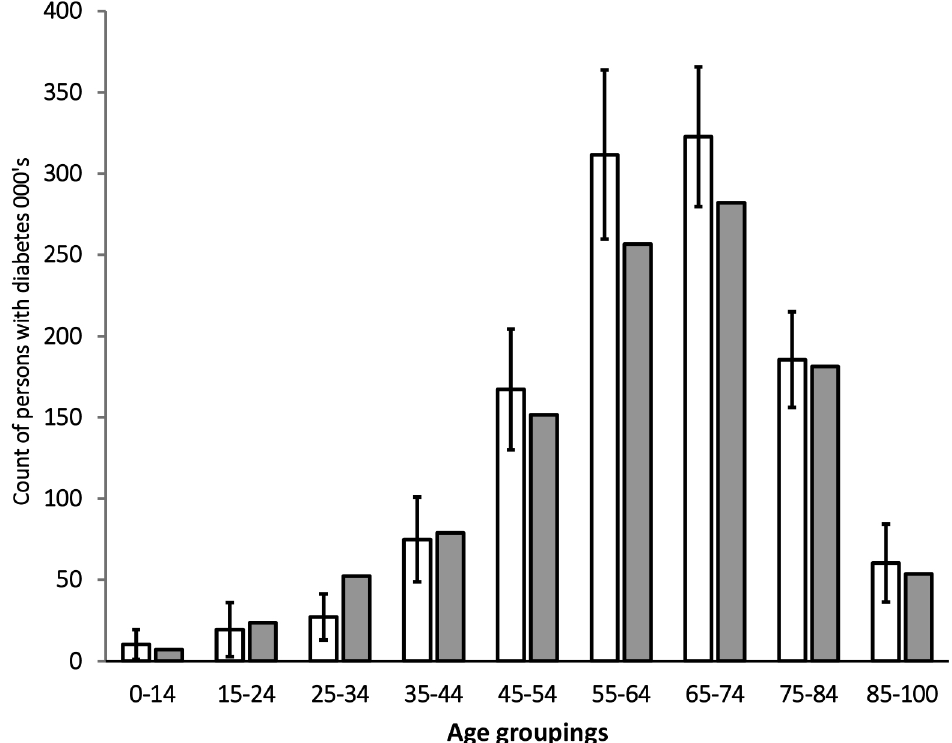
Figure 1: Comparison of National Health Survey reported diabetic population sizes (CI) by age group with Australian PBS data for 2013–14 (correlation r = .